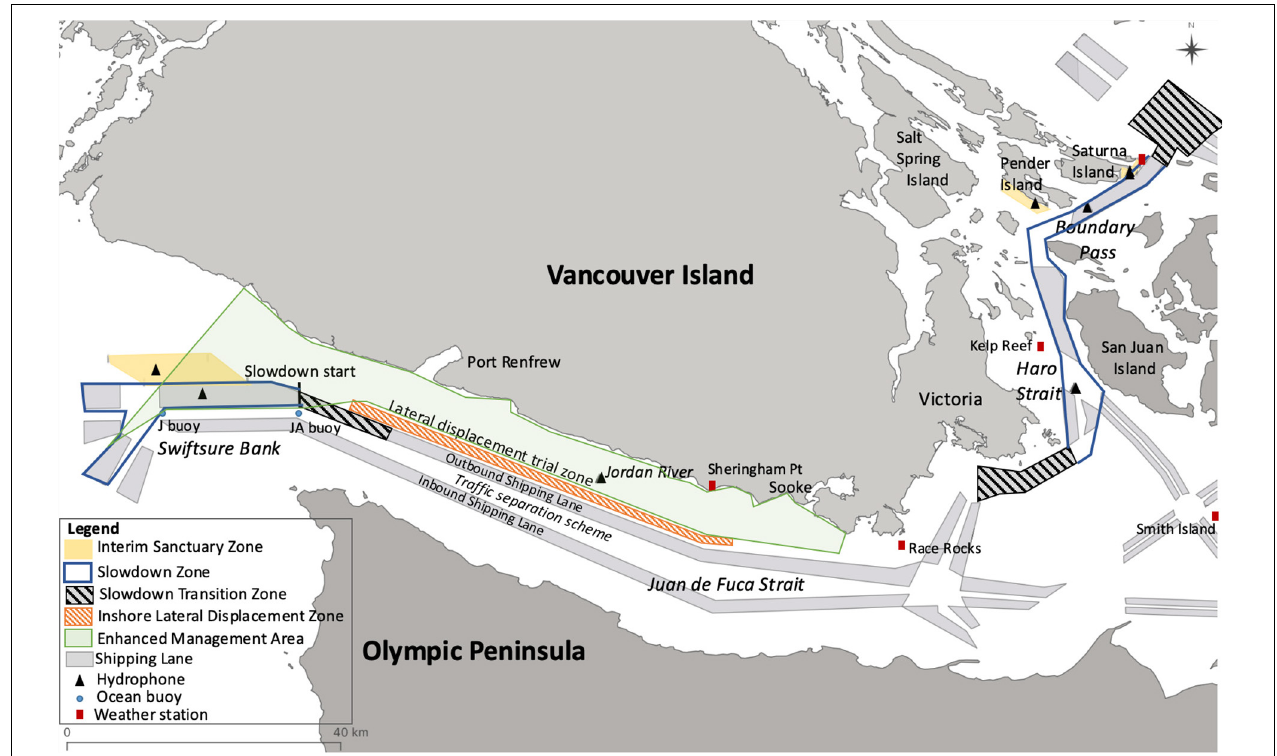
FIGURE 1 | The study area within the Salish Sea. Commercial shipping lanes are shown, as are the locations for all the management actions undertaken in the summer of 2020.